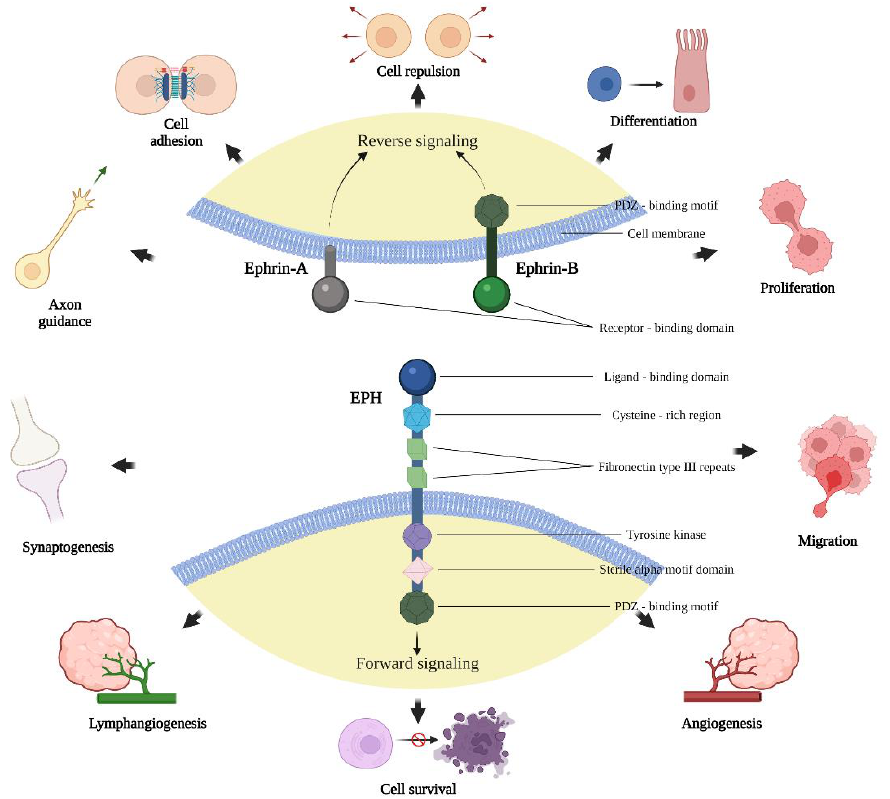
Figure 1. Structure of EPHs and ephrins and the presentation of some physiologic processes mediated through the EPH/ephrin signaling pathway. Created with BioRender.com, accessed on 2 May 2022.